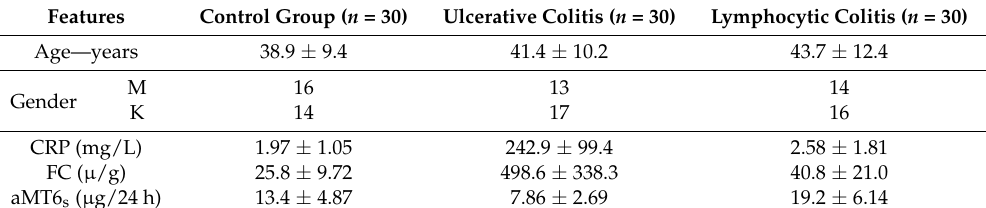
Table 1. General characteristics of subjects included in the study and some initial laboratory results;